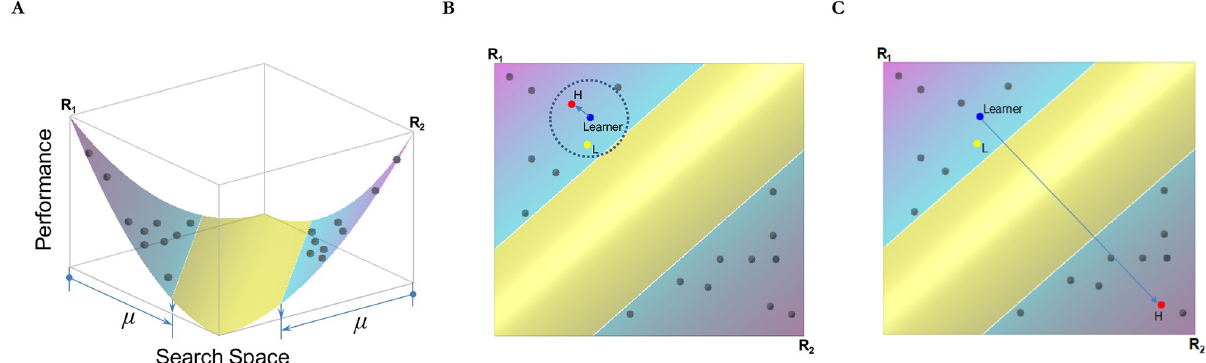
Fig 1. Learning on a two-peaked landscape with limited learning targets. (A) Performance landscape indicating there are two knowledge sets at two endpoints denoted by R 1 and R 2 . (B) A contour plot view illustrating how learning unfolds under focused exploration (i.e., a small σ value; σ indicates search boundary). H and L indicates a high and a low performer within σ . (C) A contour point view in the case of broad exploration.